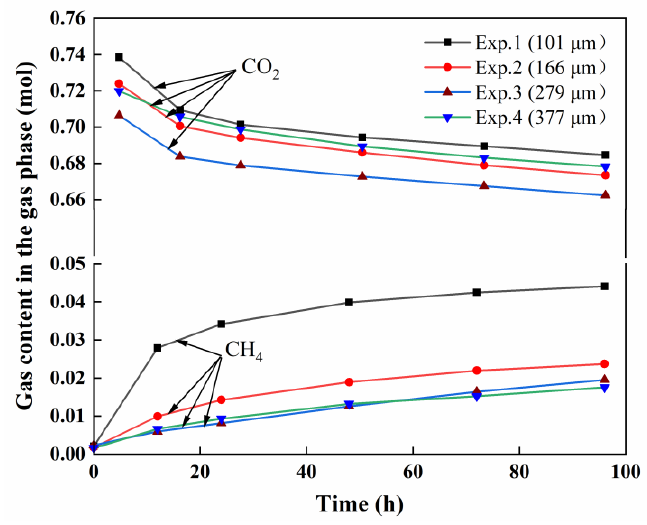
Figure 7. Variation in the total gas content in the reactor for Experiments 1, 2, 3, and 4.